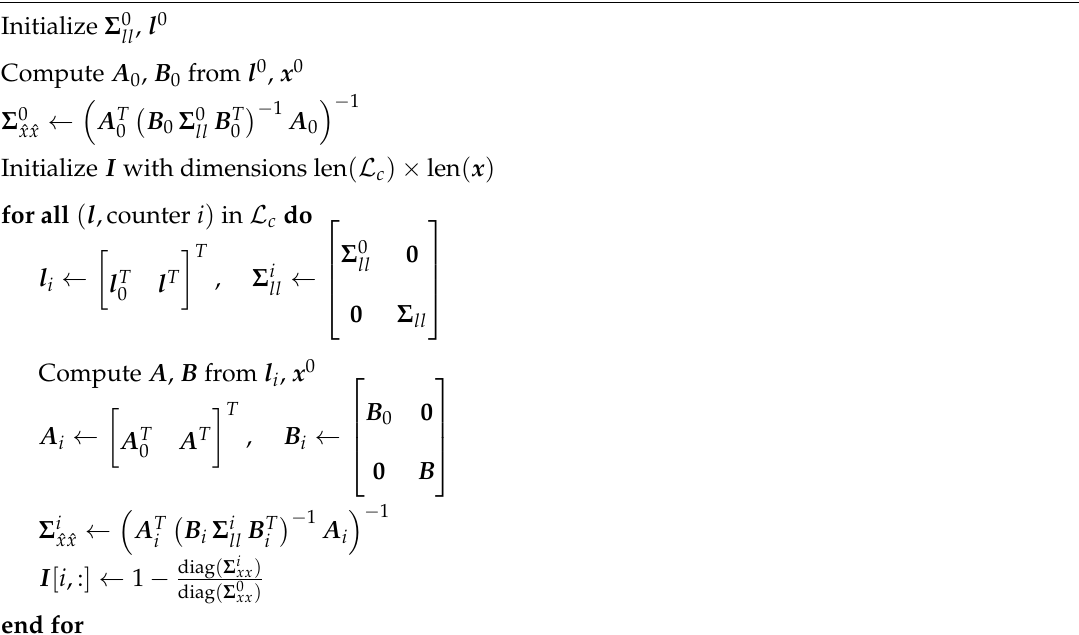
Algorithm A1 Adjustment Sensitivity